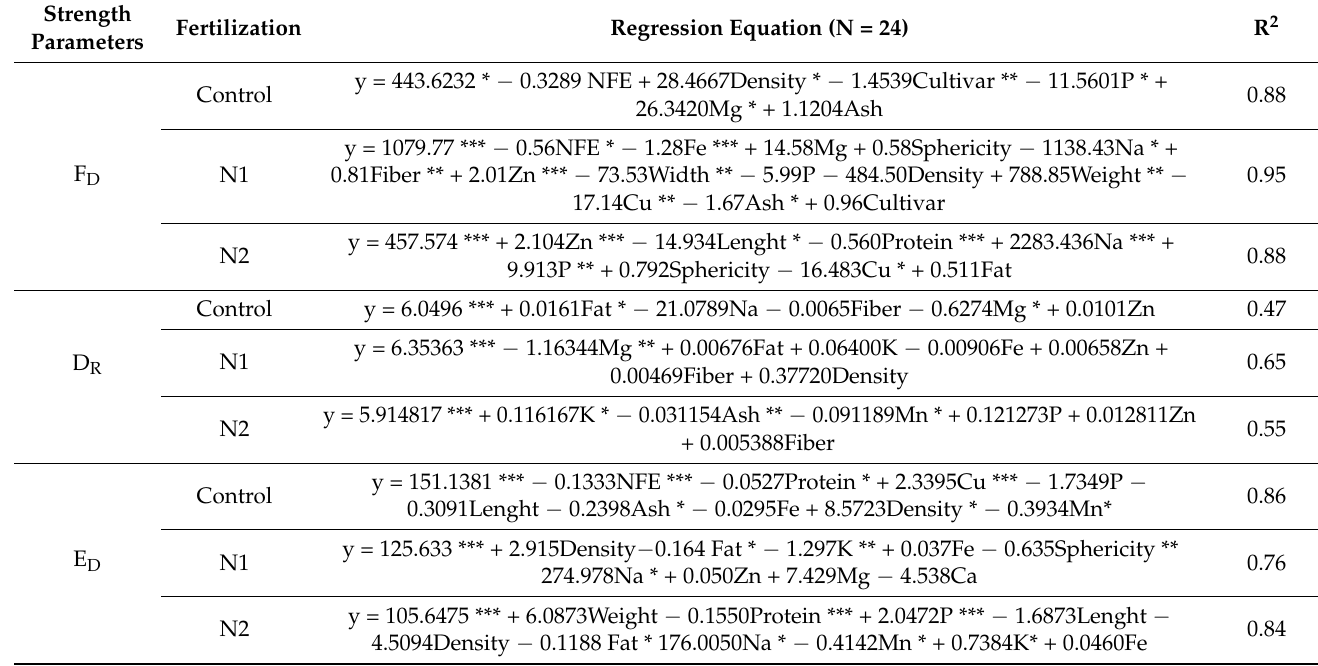
Table 8. Regression equation for mechanical properties of pea seeds dependent on fertilizer treatment. Strength Parameters